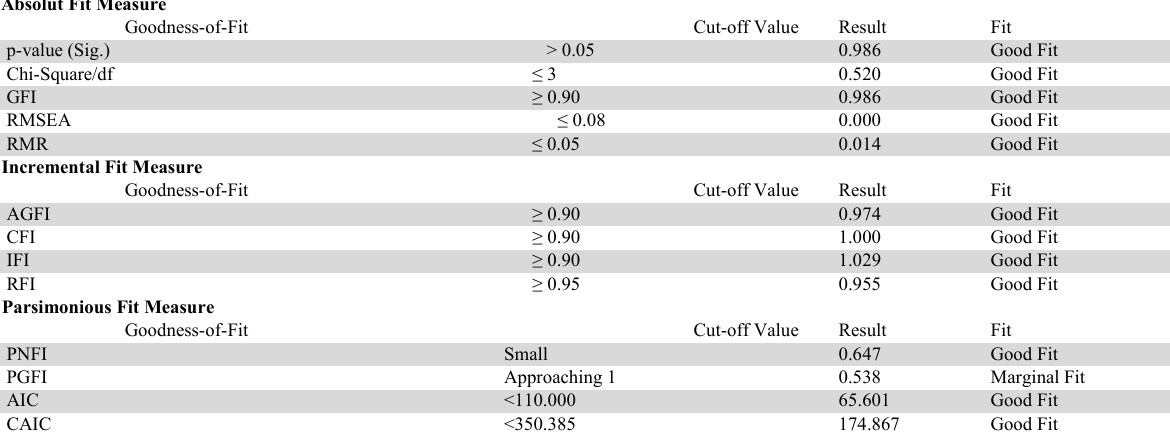
Goodness of Fit of Confirmatory Factor Analysis (CFA) Model of Organizational Communication (X2) Absolut Fit Measure Goodness-of-Fit